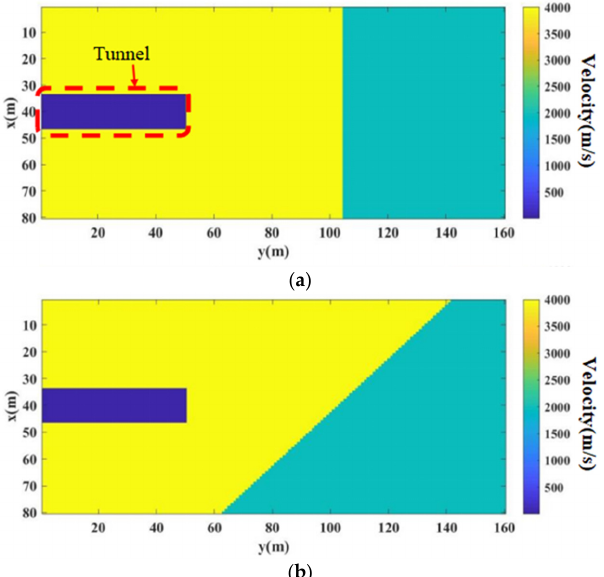
Figure 4. ( a ) A 90° lithologic interface rock wave velocity numerical model, where the red dotted line indicates the tunnel environment. Its specific observation method is shown as Figure 3. ( b ) A 45° lithologic interface rock wave velocity numerical model.